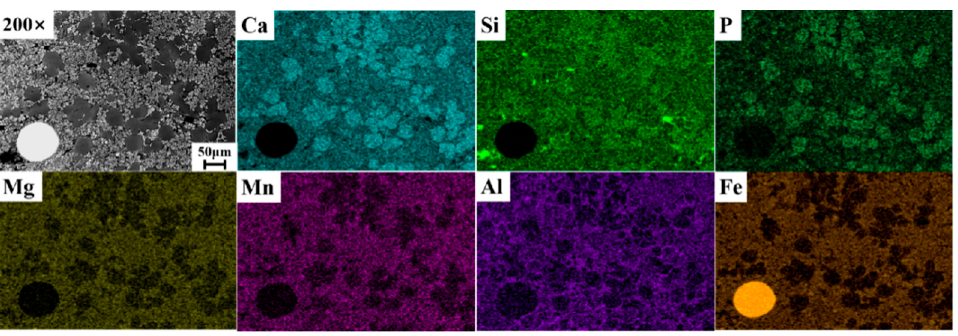
Figure 6. Element distribution results of dephosphorization slag at 1405